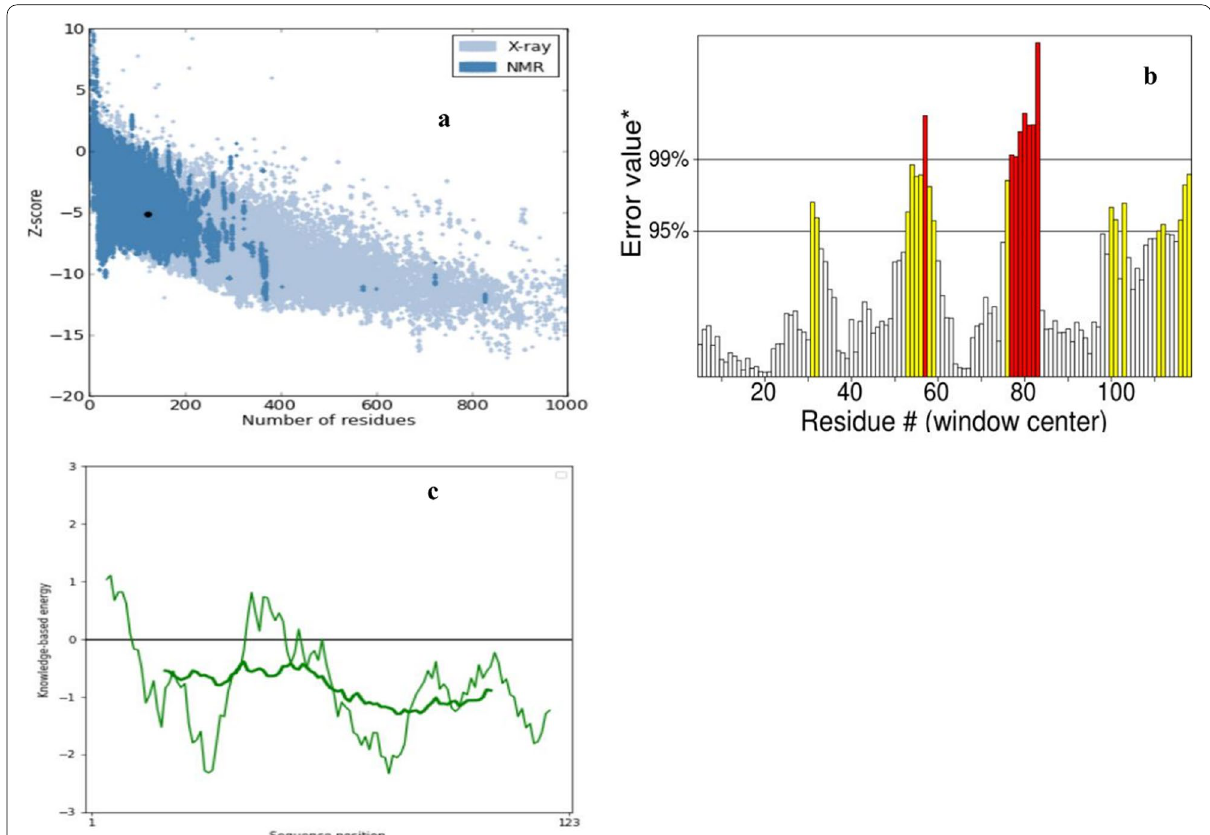
Fig. 9 ( a ) ProSA-web z-scores of all protein chains in PDB determined by X-ray crystallography (light blue) or NMR spectroscopy (dark blue) with respect to amino acid chain length. The z-scores of AmCoc is highlighted as large dots Z-score for template protein structure–AmCoc -4.92; ( b ) SAVES ERRAT graph of AmCoc; ( c ) Energy plot of